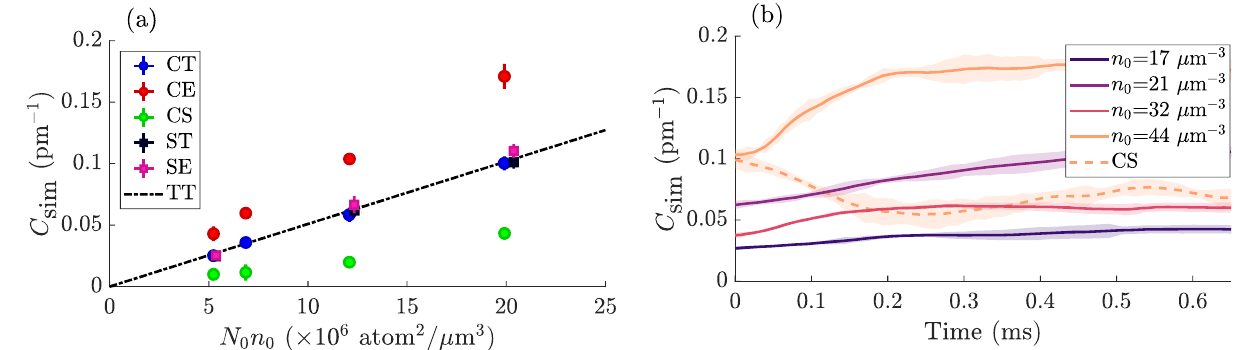
Figure 3. Simulations of release from the trap. ( a ) Steady-state values of the simulated contact. Simulations of condensates released from a cigar-shaped trap (CT) are consistent with the Tan theory (TT) before release, and show an increase in contact after the trap release (CE). A slow relaxation of the transverse trapping frequencies (CS) shows a decrease in line with the predicted value of the lower density. Spherical traps (ST,SE) lack any directions of tight confinement, wherein a longer interaction time prevents the escape of depleted particles as seen in cigar traps. ( b ) The time-dependence of the contact stabilizes after a time on the order of 1 /ω x , several hundred µ s. The expanded contact is consistently about 1.7 times the Tan theory. For comparison, the experimental control pulses are implemented after 2 ms of expansion. When the transverse trapping frequencies are slowly (1.2 ms) reduced by half (dotted line), the in-situ contact relaxes on a faster timescale than the